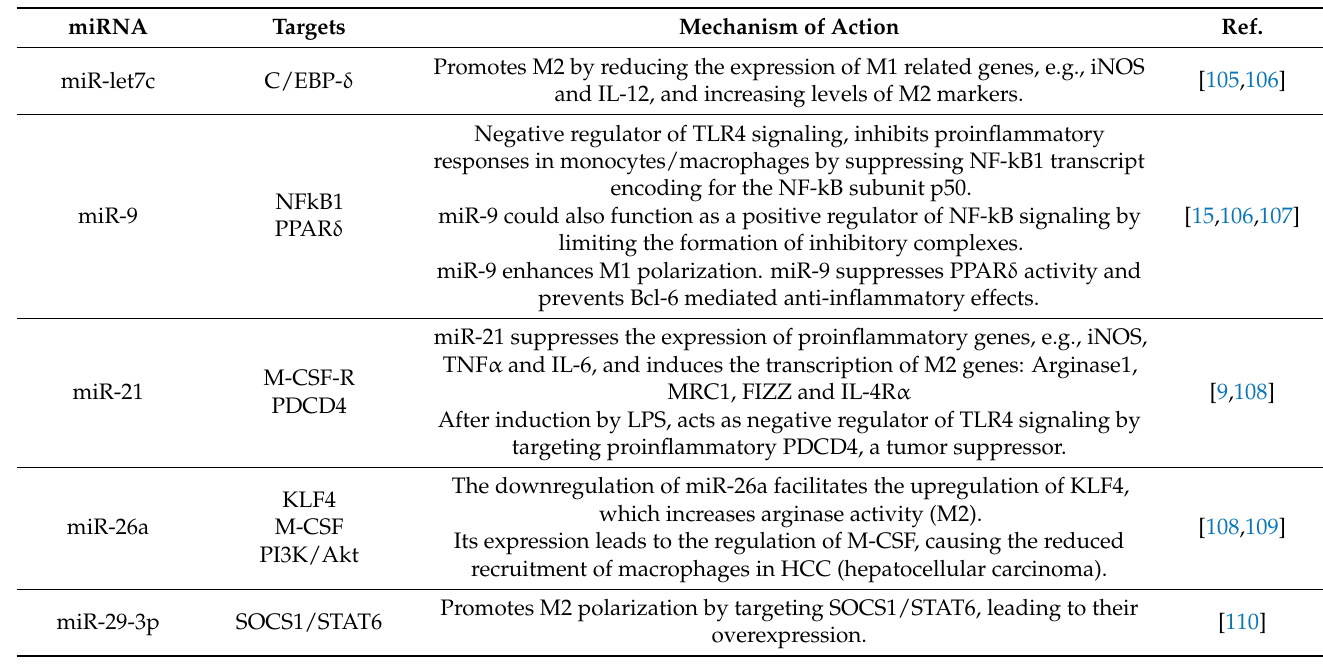
Table 2. Summary of miRNAs involved in polarization of